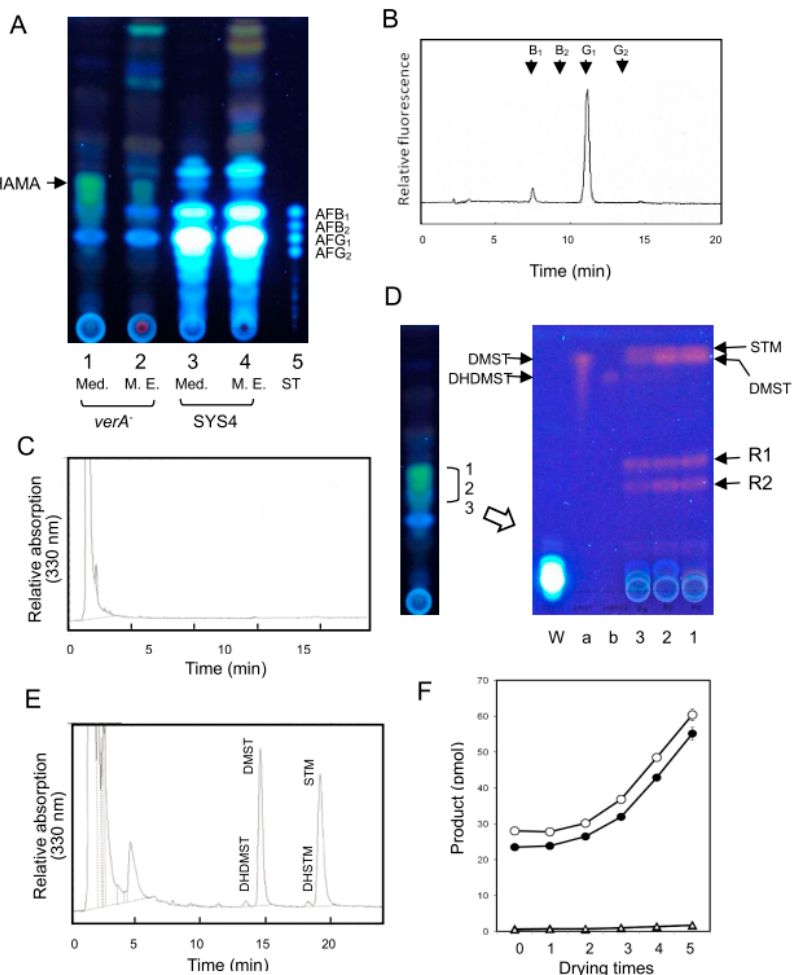
Figure 3. The production of a new intermediate, HAMA, and changes of the intermediate to DMST and STM. ( A ) Characterization of metabolite(s) of the verA disruptant. After the tip culture of the verA disruptant and SYS4, an extract (50 µ L) of culture medium (1, 3) and mycelial extract (50 µ L) (2, 4) of the verA disruptant (1, 2) and SYS4 (3, 4) were analyzed by TLC using solvent ( A ). ( B ) The production of AFB 1 and AFG 1 from HAMA by the tip culture method. NIAH-26 mutant was fed with TLC-purified HAMA pigment in YES medium, and the resulting culture medium was analyzed by HPLC using solution ( A ). ( C ) HPLC analysis of HAMA. Extract of the culture medium of the verA disruptant was analyzed by ODS HPLC using solution ( D ). ( D ) The change of TLC-purified HAMA to other substances. The broad yellow fluorescent band (HAMA) on the TLC plate (as shown in panel A) was divided into three parts (1–3), and each part was extracted and then re-analyzed by TLC using solution B. Four red substances (STM, DMST, R1, and R2) were observed. a, DMST; b, DHDMST. ( E ) The non-enzymatic conversion of HAMA to DMST and STM and contaminated DHHAMA to DHDMST and DHSTM. The drying of TLC-purified HAMA under N 2 gas followed by solubilization was repeated five times, followed by an HPLC analysis as described in panel C. Standard samples of DMST, STM, and DHDMST were also analyzed. ( F ) The production of DMST and STM from HAMA by the repetition of drying and solubilization. The same procedures as those described in panel E were done from zero to five times, followed by an HPLC analysis. The amounts of DMST (closed circles), STM (open circles), DHDMST (closed triangles), and the suspected DHSTM (open triangle) were